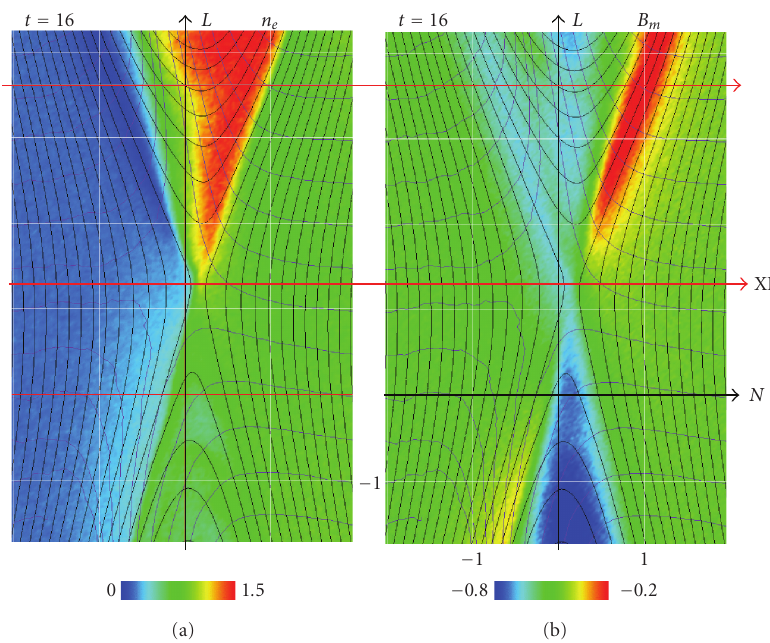
Figure 10: Results from the ( V MSH , B Mo ) = (0, − 0 . 5) case shown in the same format as Figure 7. The spatial dimension is [ L XL − 3, L XL + 3] × [ N XL − 2, N XL +2]. The time is t = 16. The part of the upward jet having density higher than the magnetosheath value is accompanied by the band of B M ∼ 0 on the magnetosheath side of it.